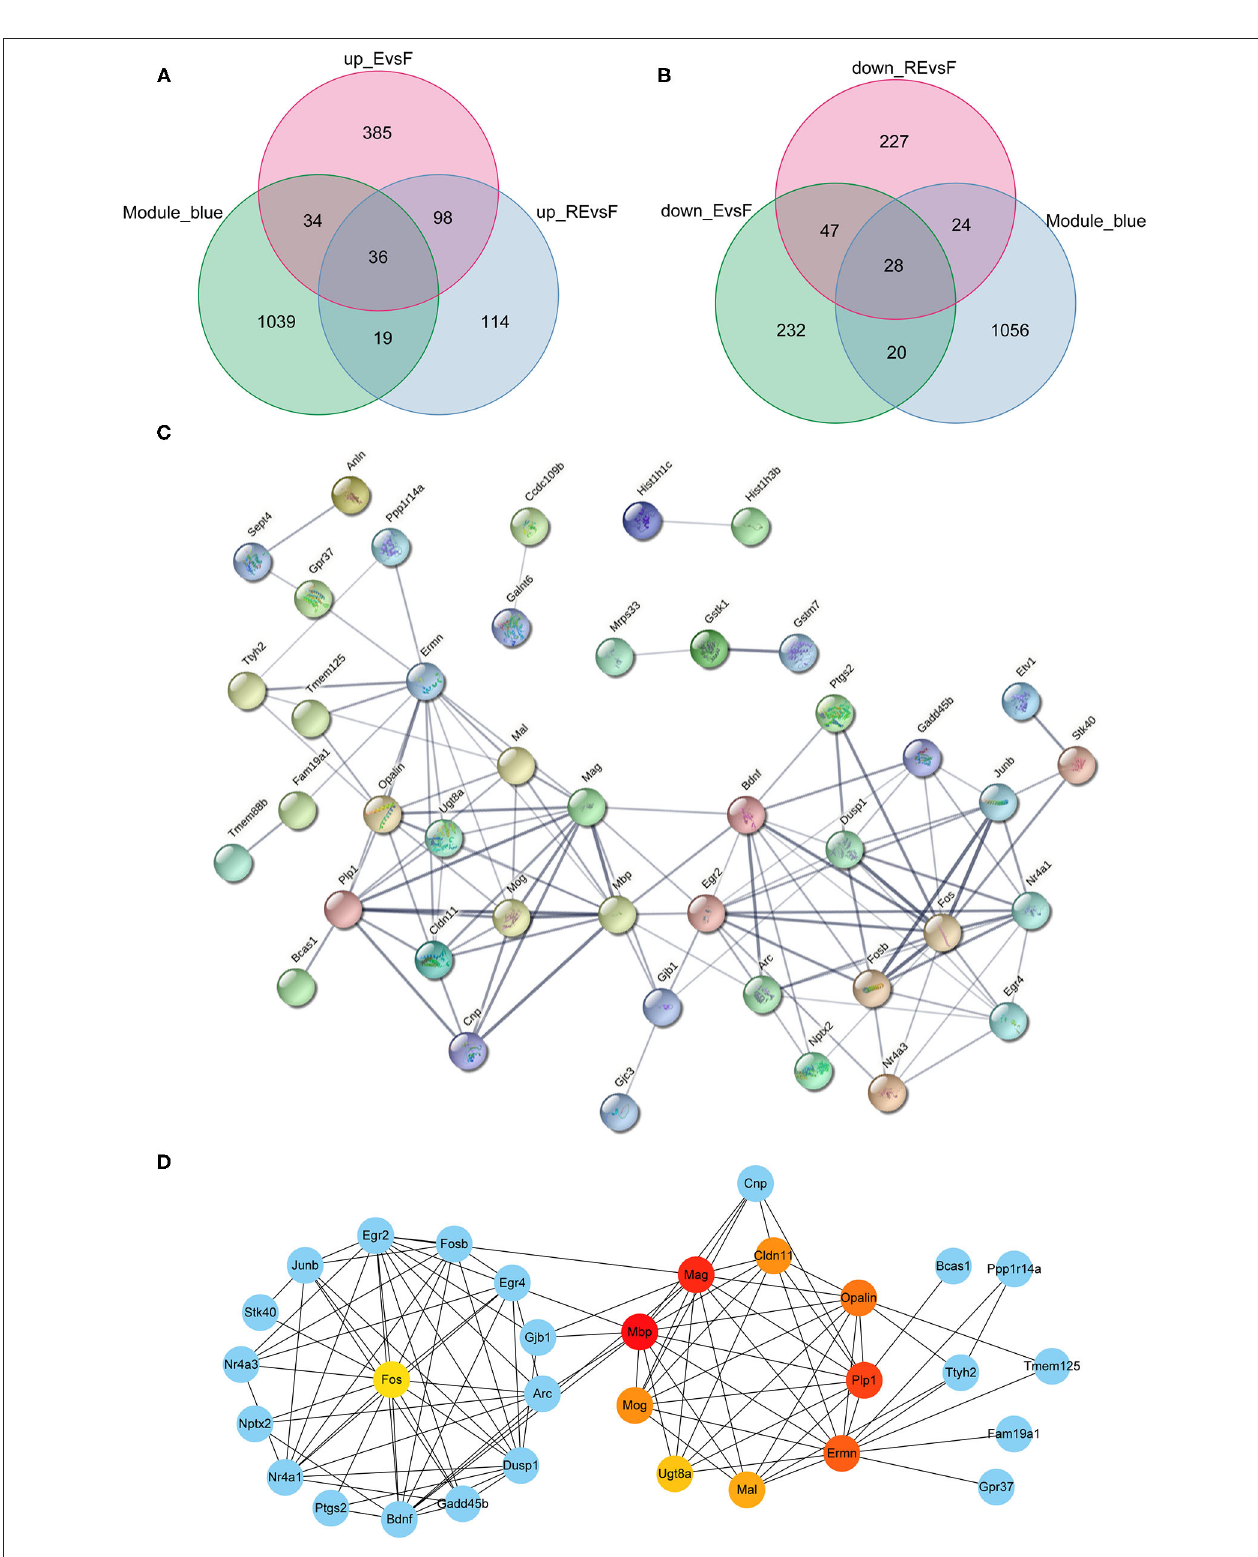
FIGURE 7 | Analysis of key genes in F and E/RE groups. (A,B) The obtained mRNAs were presented by Venn diagram. (C,D) PPI network was established by using the obtained mRNAs. F, Fear memory formation group. E, Fear memory extinction group. RE, retrieval-extinction group; PPI, protein-protein interaction.